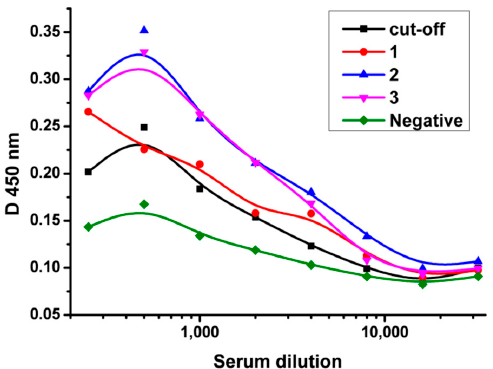
Figure 1. Enzyme-linked immunosorbent assay (ELISA) detection of antibodies against LPS of Brucella abortus in cattle serum.